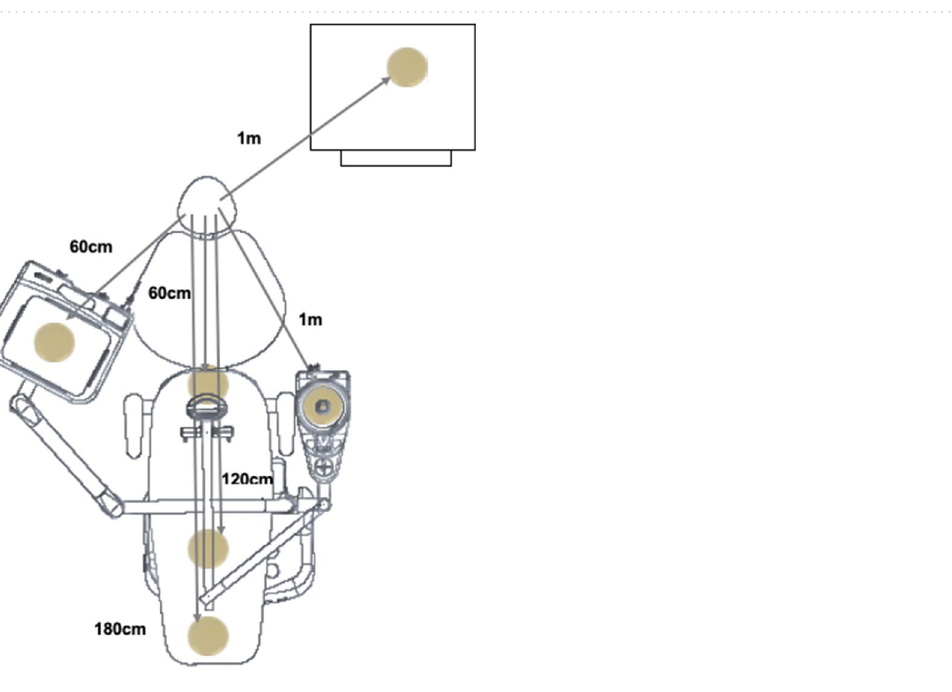
Figure 2. Positioning the BHI agar plates at distances of 60, 120, and 180 cm from the coronal access point and three additional plates, one on the right side at 60 cm, one on the left side at 1 m and other behind the operator at a distance of 1